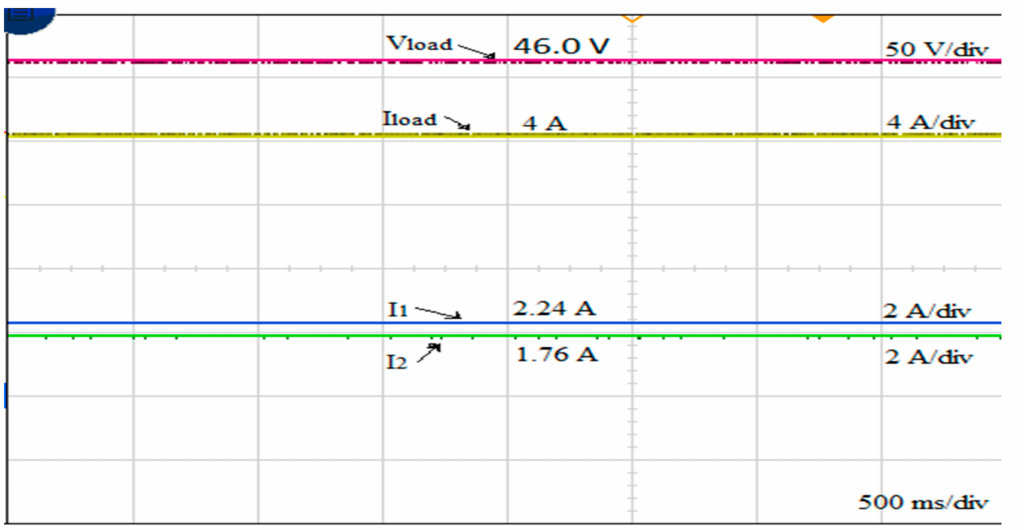
Figure 16. Experimental results for different cable resistances for the novel droop